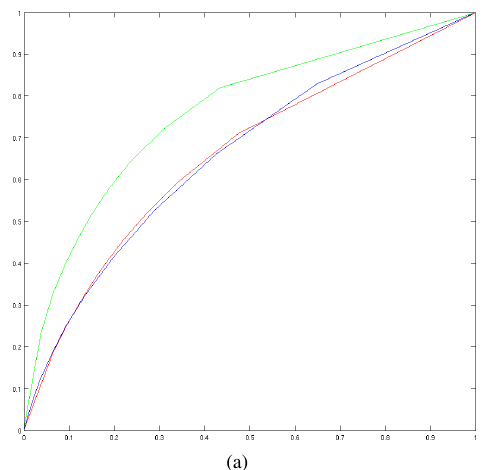
Figure 4: ROC curves under usage of different textons green: proposed method; blue: filters independently applied to all color-channels; red: grey-scale textons